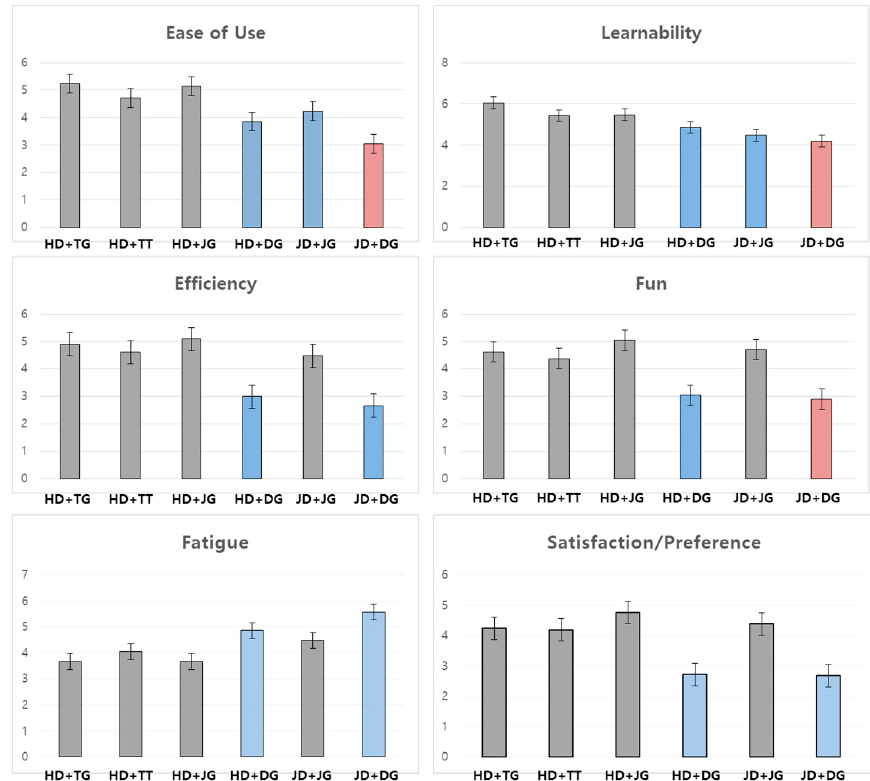
Figure 12. Usability questionnaire (six categories) scores for the six interfaces.